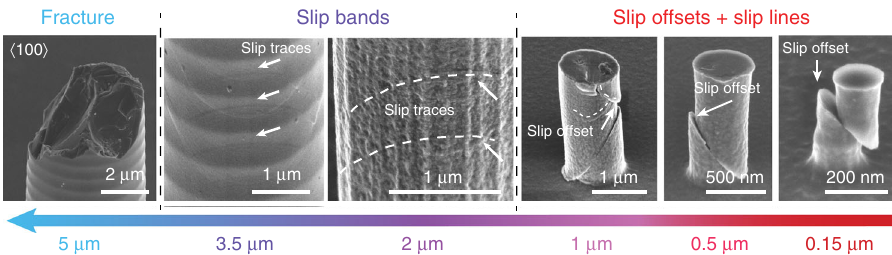
Fig. 2 Size-dependent transition in Si deformation. Scanning electron micrographs of surface morphologies of lithographic Si pillars compressed at ambient temperature with a diameter from 5 to 0.15 μ m (tilt view angle